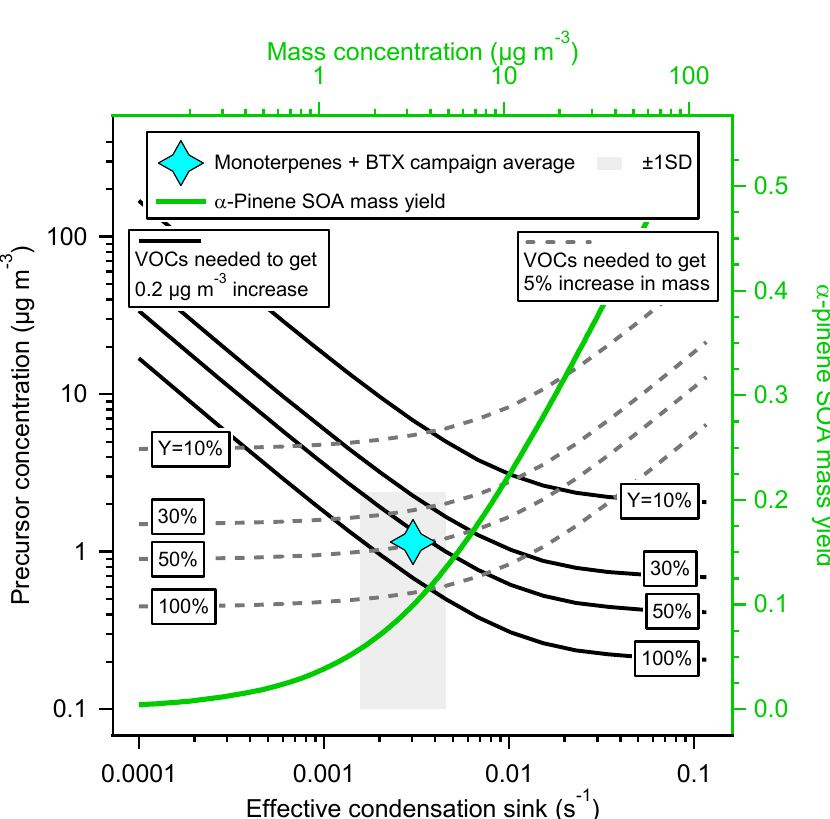
Figure 5. The precursor concentration needed to measure either a 0.2 µg m −3 or a 5% increase in particle mass at different effective condensation sinks and particle mass yields (boxes). The top axis shows the corresponding mass concentration at each condensation sink parameterized from the campaign data. The blue star shows the campaign average particle mass concentration and the concentration of common precursors (monoterpenes, benzene, toluene and xylenes), with ±1σ in grey. For comparison, the secondary organic aerosols (SOA) mass yield of α-pinene from Ahlberg et al. (2017) as a function of organic mass is added (green axes and line).